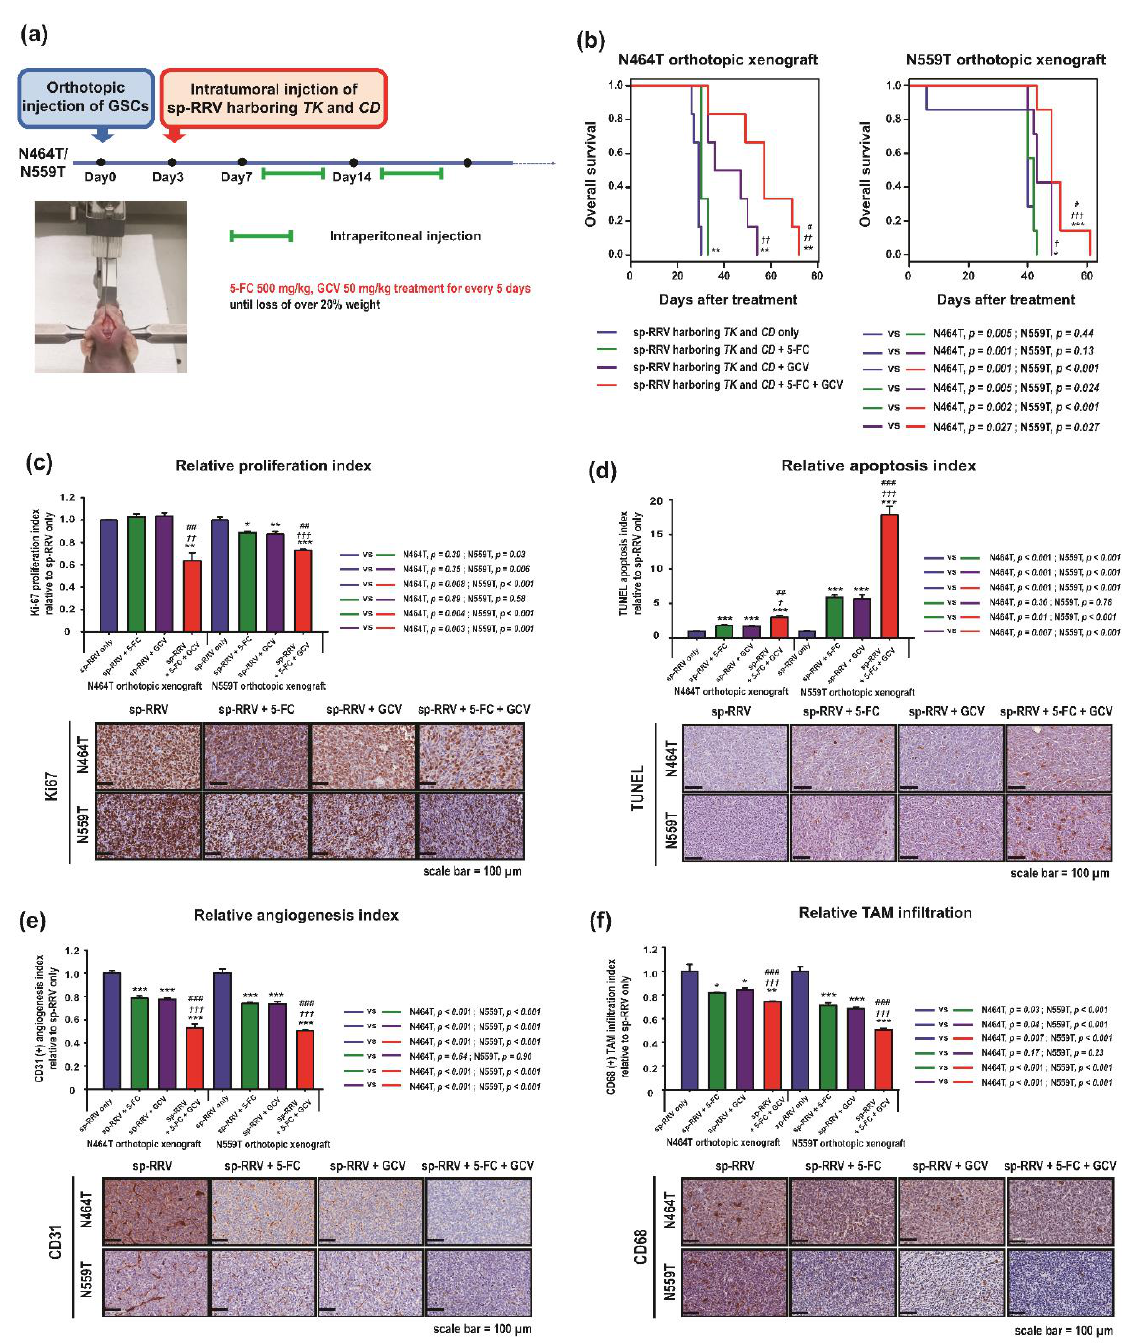
Figure 4. Anti-tumor effects, including inhibition of cell proliferation, induction of cell apoptosis, anti-angiogenesis, and depletion of tumor-associated macrophages (TAMs) of 5-FC combined with GCV in the spRRVe-sEF1 α - TK and sRRVgp-sEF1 α - CD sp-RRV vector systems are greater than those achieved using 5-FC or GCV alone. ( a ) Schematic diagram of the in-vivo experimental protocol. Blue and red arrows indicate orthotopic injection of two patient-derived GSCs (N464T and N559T) into BALB / c nude mice and intratumoral injection of spRRVe-sEF1 α - TK and sRRVgp-sEF1 α - CD , respectively. The long purple label represents intraperitoneal injection of PBS ( n = 6), 5-FC (500 mg / kg, n = 6), GCV (50 mg / kg, n = 6), and a combination of 5-FC and GCV ( n = 6), administered for 5 consecutive days / week until the mice were sacrificed. The mice were euthanized when there was more than 20% body weight loss. ( b ) Kaplan-Meier survival curves. ( c , d ) Analysis of proliferation index (Ki-67) ( c ) and apoptosis index (Terminal deoxynucleotidyl transferase dUTP nick end labeling (TUNEL) assay) ( d ) by immunohistochemistry (IHC). ( e , f ) IHC analysis of CD31 ( e ) and CD68 ( f ) expression in two orthotopic xenografts of patient-derived GSCs (N464T and N559T). Representative